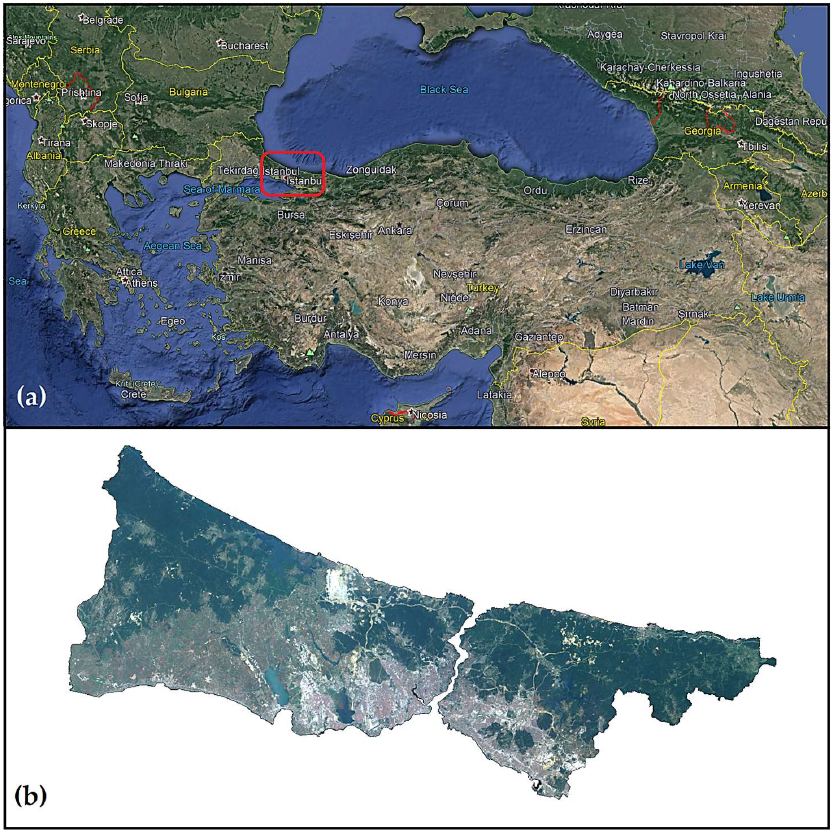
Figure 1. Study sites and overview of the images used in this research: ( a ) Geographic location of Turkey (Google Earth©). ( b ) Overview of Istanbul city from 2017-dated Landsat 8 data.